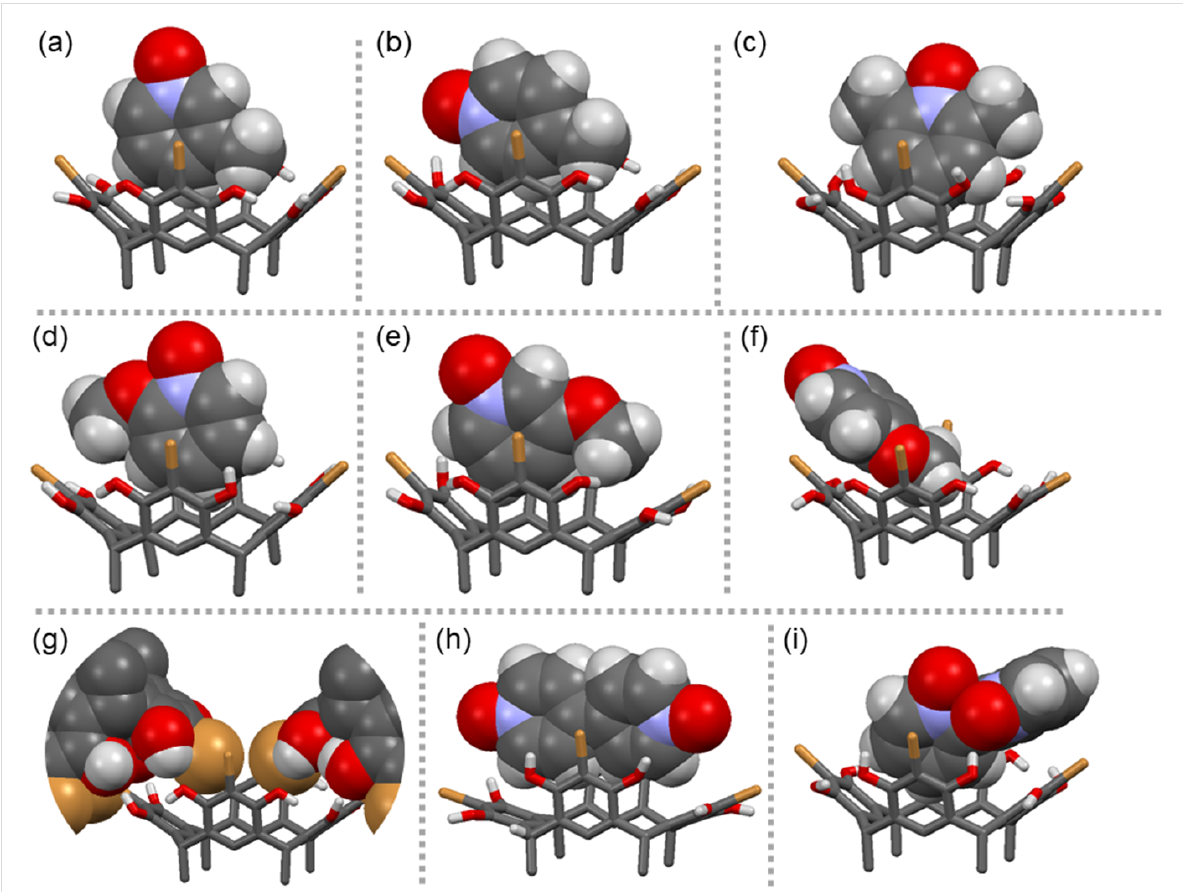
Figure 2: X-ray crystal structures of (a) 3 @BrC6, (b) 4 @BrC6, (c) 5 @BrC6, (d) 6 @BrC6, (e) 7 @BrC6, (f) 8 @BrC6, (g) BrC6 obtained from 10 +BrC6, (h) 11 @BrC6, and (i) 12 @BrC6. The endo cavity N -oxide guests are shown in CPK models, and the host in capped-stick models. The lower-rim alkyl chains and selected hydrogen atoms were omitted for viewing